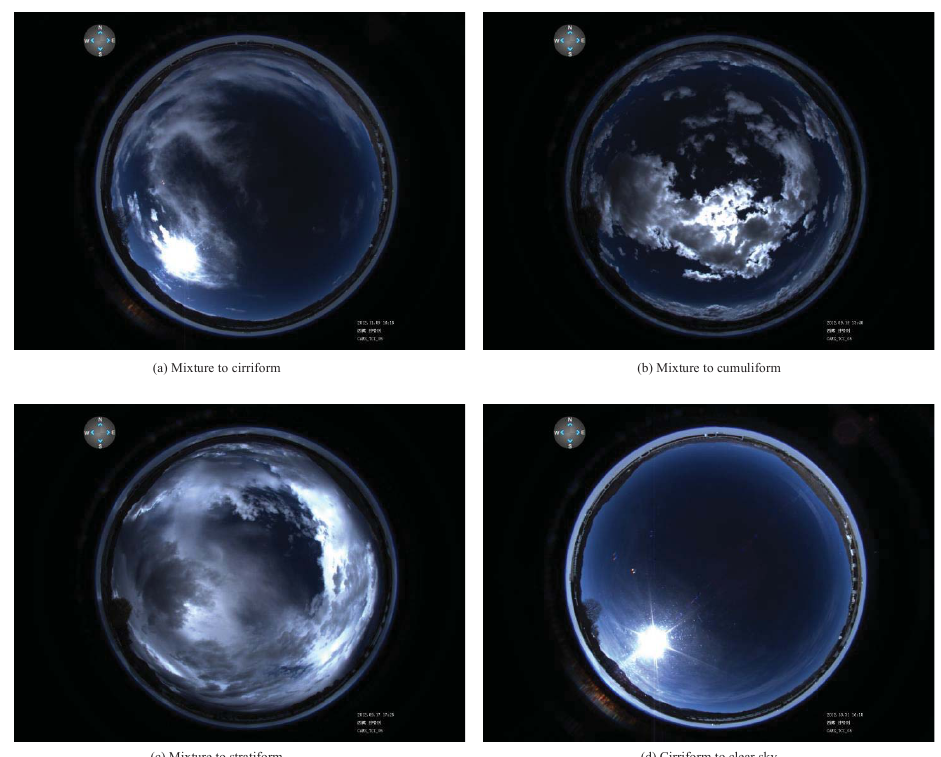
Figure 7. Some misclassified all-sky